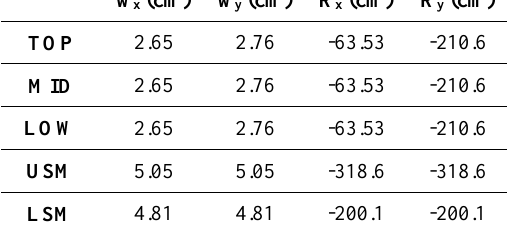
Table 1b. Starting beam waist and radii of curvature.